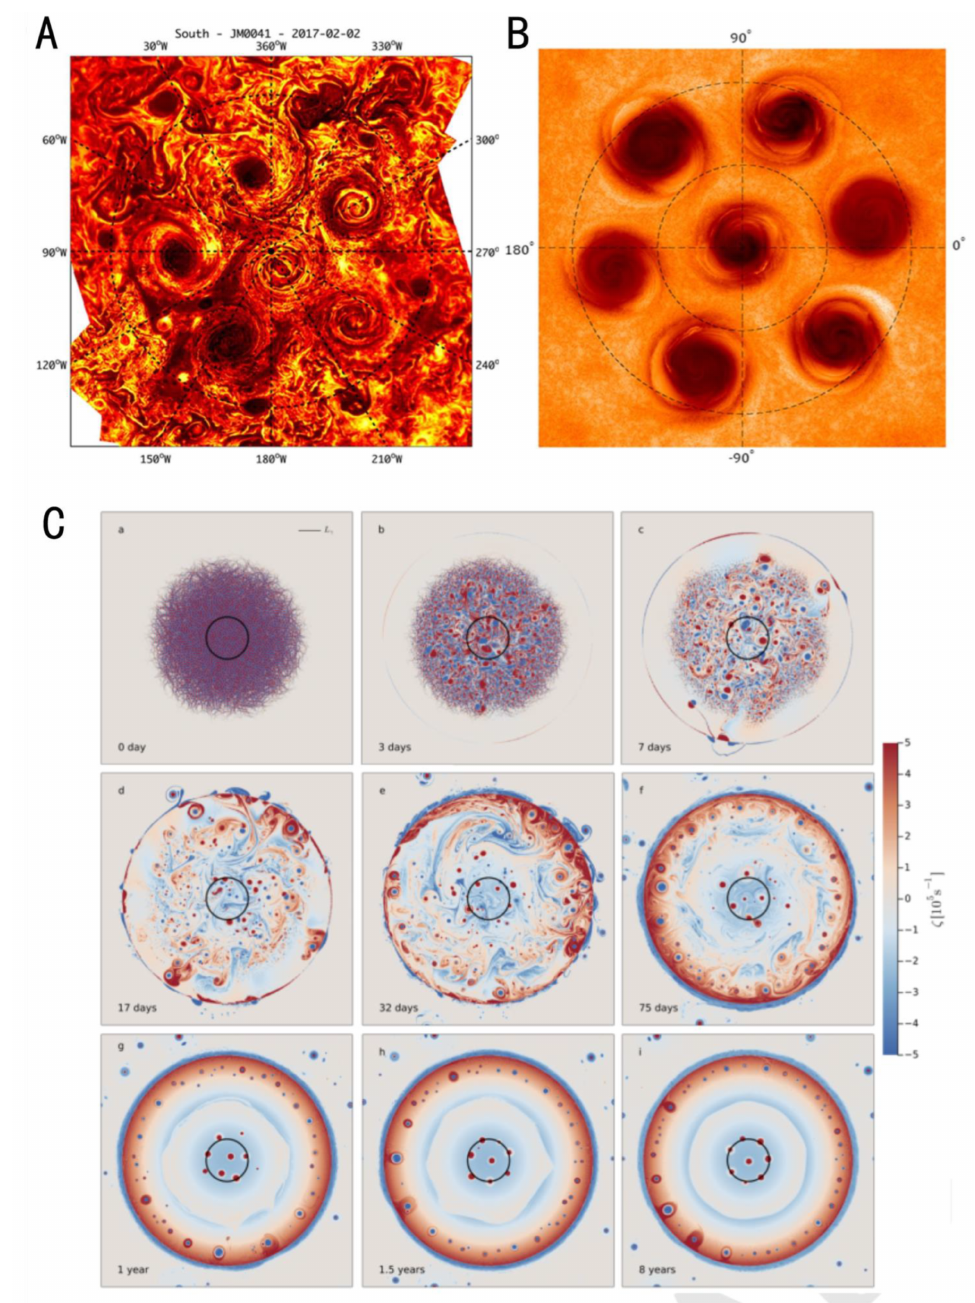
Figure 15. Jupiter Polar Cyclone Modeling. Part 2. ( A ) JIRAM Mosaic from Perijove 41 South Polar Region. ( B ) Stable Configuration of CPCs from RRRB Model. Dark colors are cool cyclonic regions. ( C ) Time Evolution of Polar Vortex Development from a Quasigeostrophic Model. ( A , B ) Reproduced from Cai et al. [227]. ( C ) Reproduced from Siegelman et al. [228] ( a – i